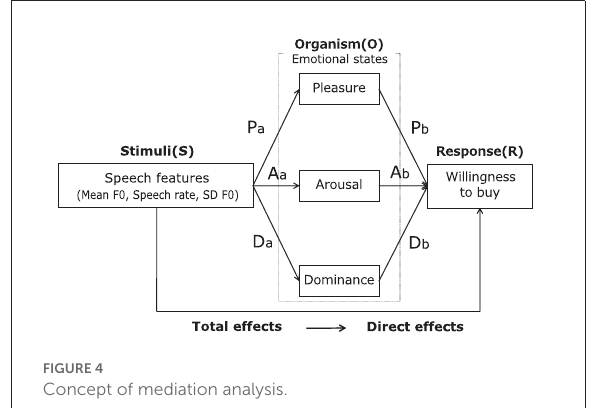
FIGURE4 Concept of mediation